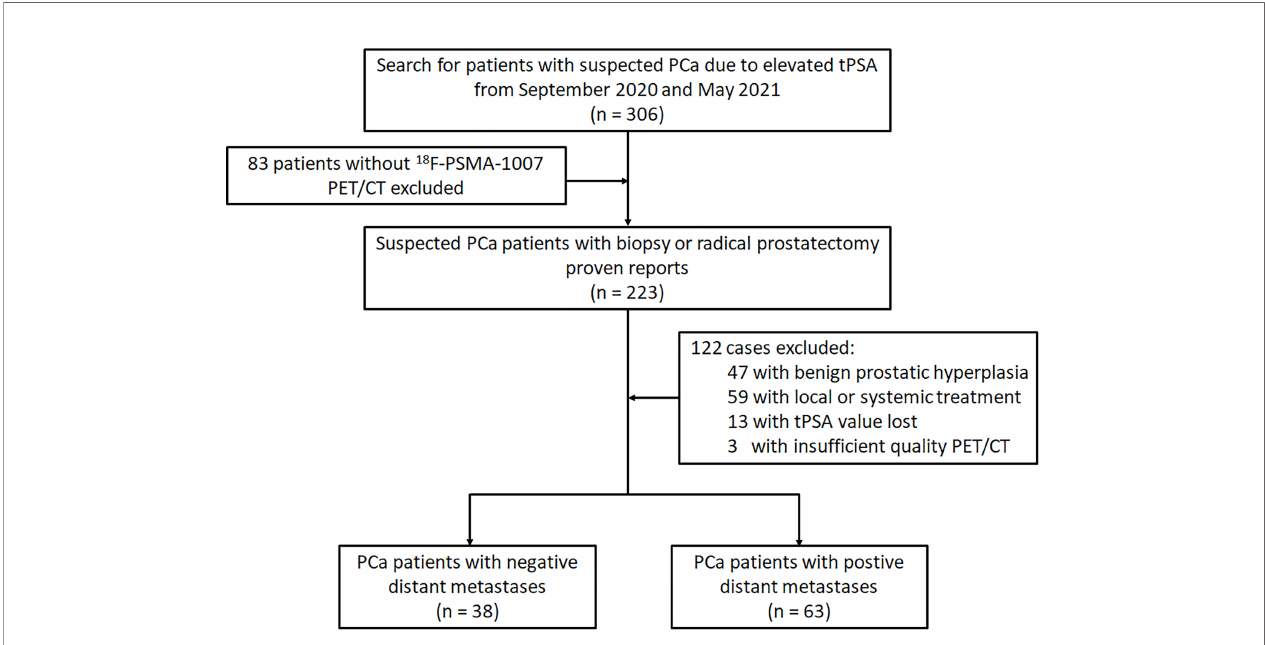
FIGURE 1 | Flowchart of the PCa patient ’ s